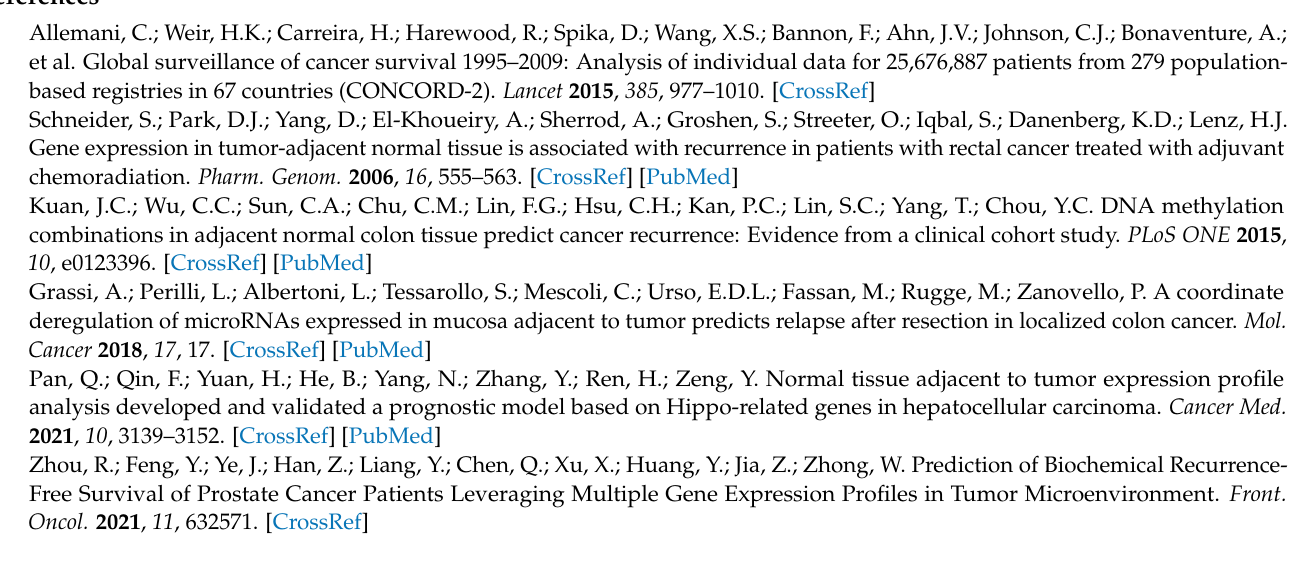
CBX8; Figure S2: Effect of CBX8 overexpression on